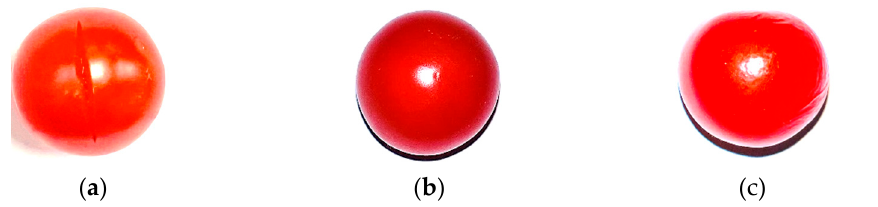
Figure 16. Examples of picking tomatoes: ( a ) Damaged fruit; ( b ) Browning fruit; ( c ) Wrinkling fruit. Therefore, based on the success rate, picking time, damage rate, browning rate, and wrinkle rate, the end-effector developed in this paper had a good fast and undamaged clamping effect, and excellent picking performance.